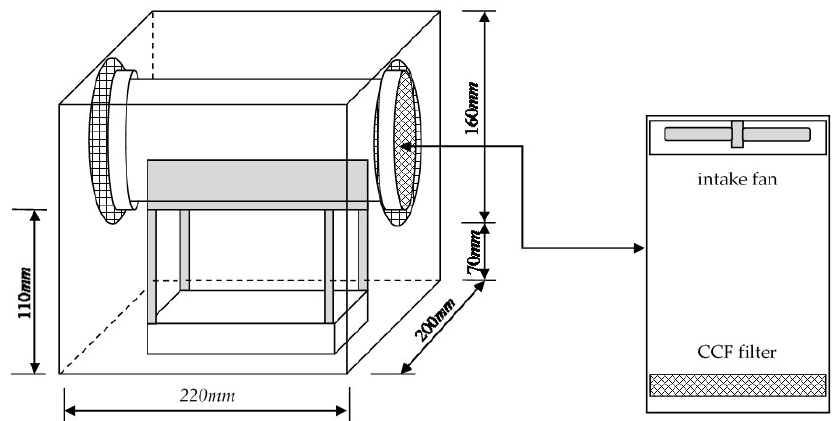
Figure 7. Schematic diagram of self-made air-cleaning device.